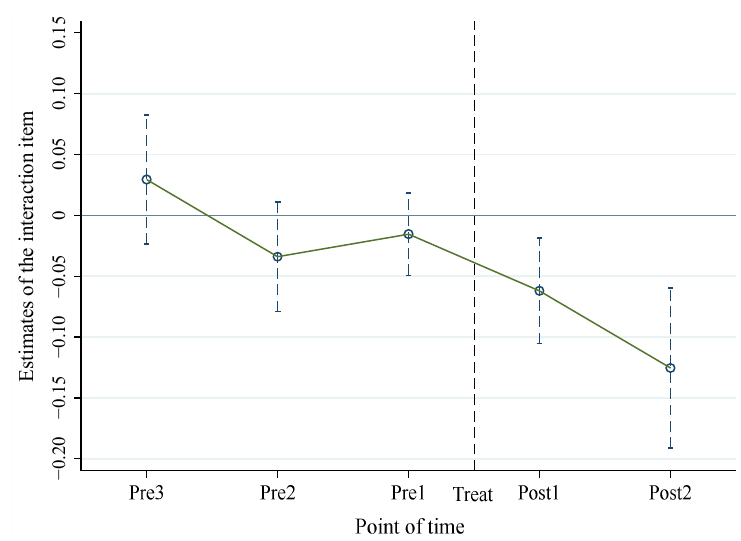
Figure 2. Changes in life satisfaction in pollution information access.